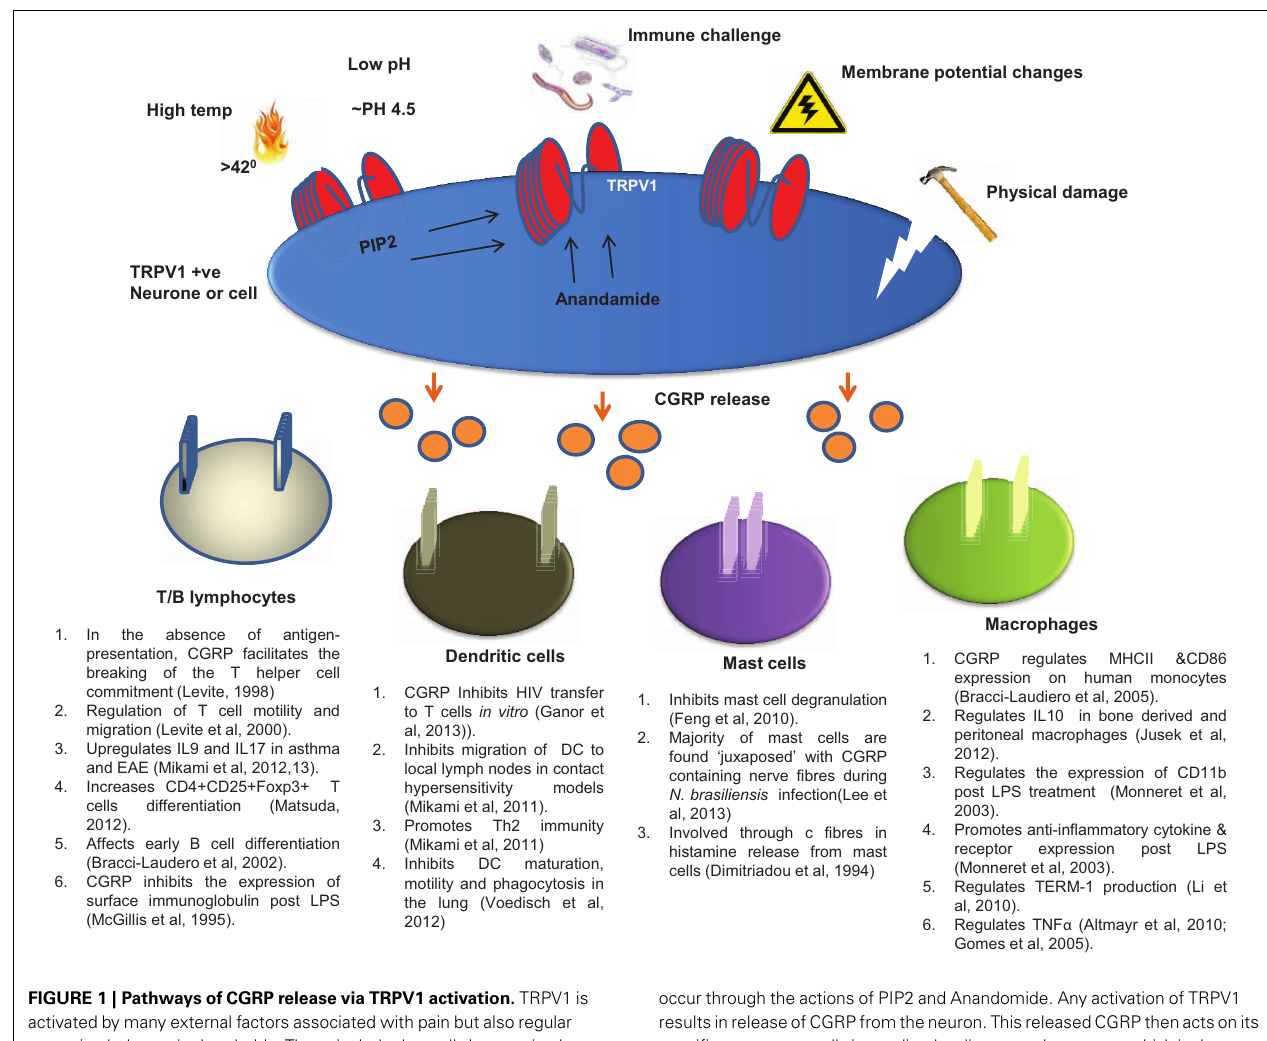
occur through the actions of PIP2 and Anandomide. Any activation of TRPV1 resultsinreleaseofCGRPfromtheneuron.ThisreleasedCGRPthenactsonits specificreceptoroncellsimmediatelyadjacenttotheneuron,whichinthecase of sensory c fibers can be lymphocytes, DCs, mast cells, macrophages or cells within the hemopoietic microenvironment of the bone marrow (not shown). The range of activities stimulated by CGRP are listed below each cell